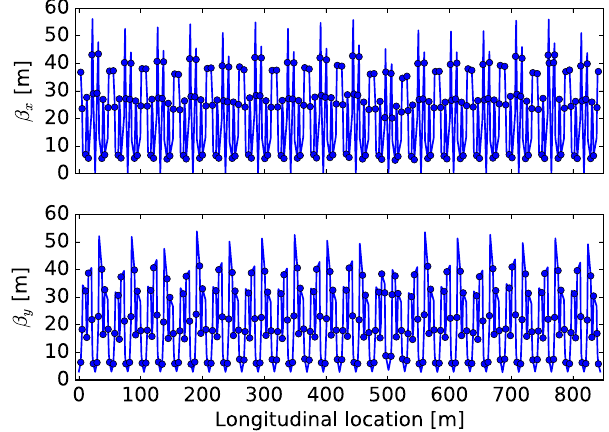
FIG. 1. The lattice β -functions along the ESRF storage ring. The markers refer to BPM